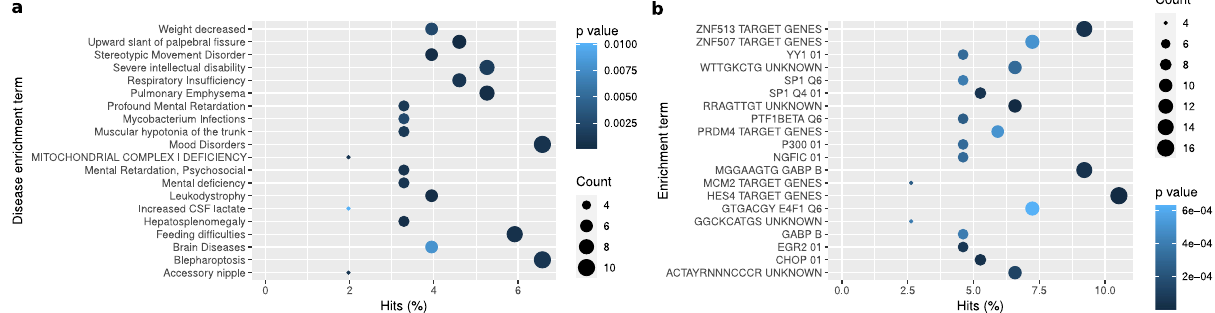
Fig. 5 Disease and transcription factor targets enrichment analysis of DLB-associated genes. a DisGeNET analysis for the DMC-associated genes using Metascape. b Transcription factor targets enrichment analysis of the DMC-associated